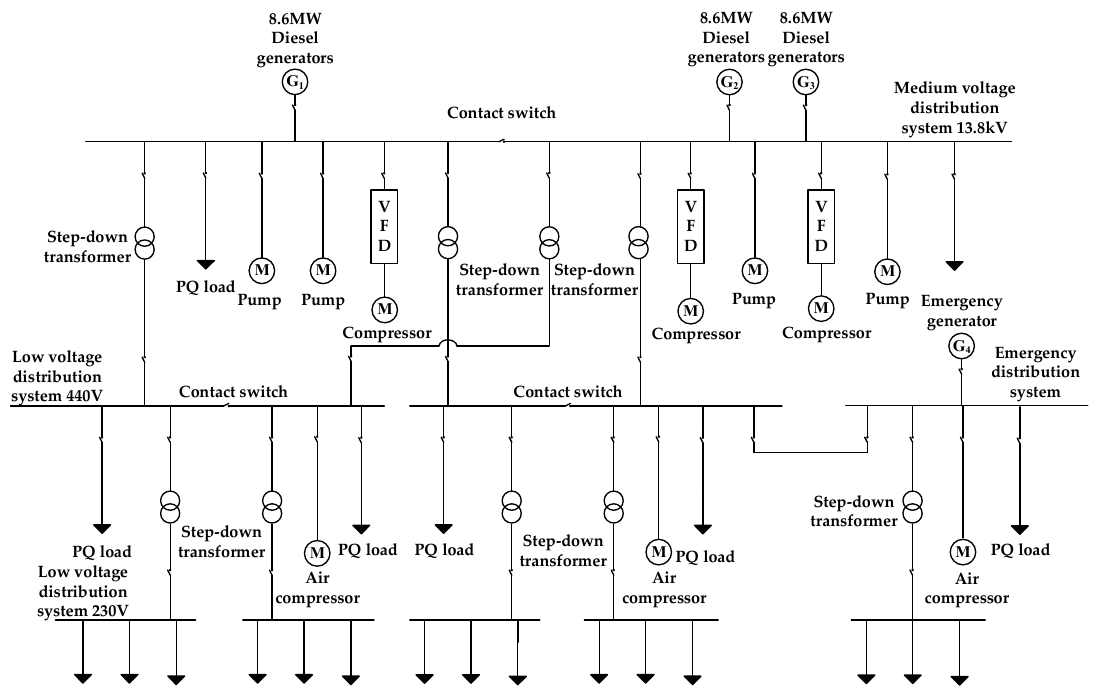
Figure 2. Power system structure diagram of deep-water semi-submersible production platform.